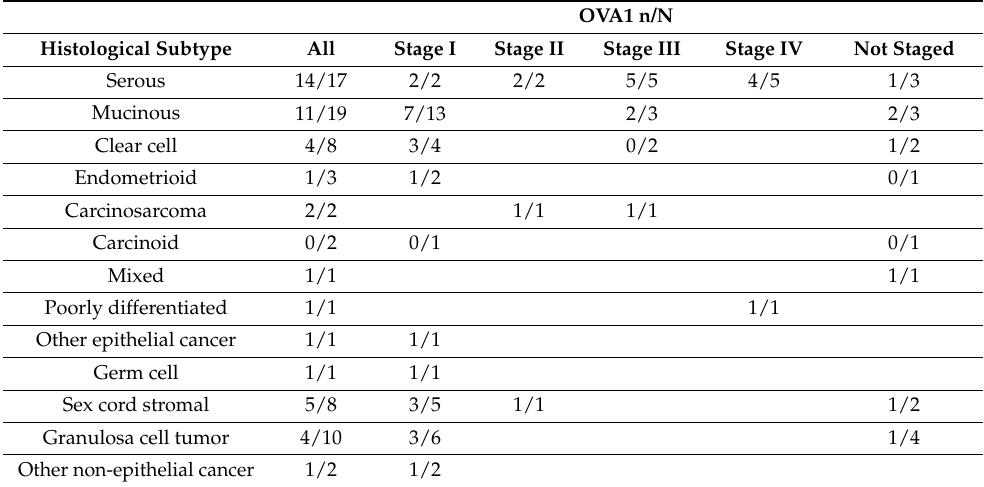
Table 4. OVA1 Performance by Histological Subtype and FIGO Stage When Low-Risk CA125